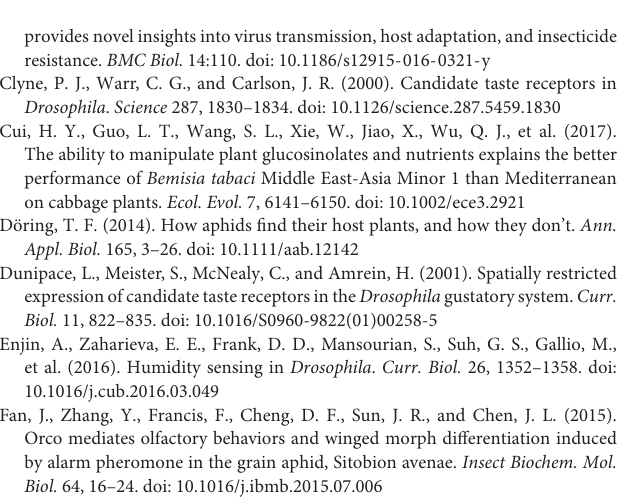
Supplementary Figure S1 | Homology analyses results. The BLASTx annotations of A. spiniferus antenna transcripts. (A) E-value distribution. (B) Similarity distribution. (C) Species distribution. Supplementary Figure S2 | Functional annotation of A. spiniferus transcripts based on gene ontology (GO) categorization. Supplementary Figure S3 | Alignment of OBPs (A) and CSPs (B) of A. spiniferus . Supplementary Table S1 | Amino acid sequences of chemosensory genes from A. spiniferus and other insects that used for phylogenetic analyses. Supplementary Table S2 | Primers used in this work. Supplementary Table S3 | Summary of A. spiniferus transcriptome annotation. Supplementary Table S4 | Transmembrane domains in ORs, GRs and